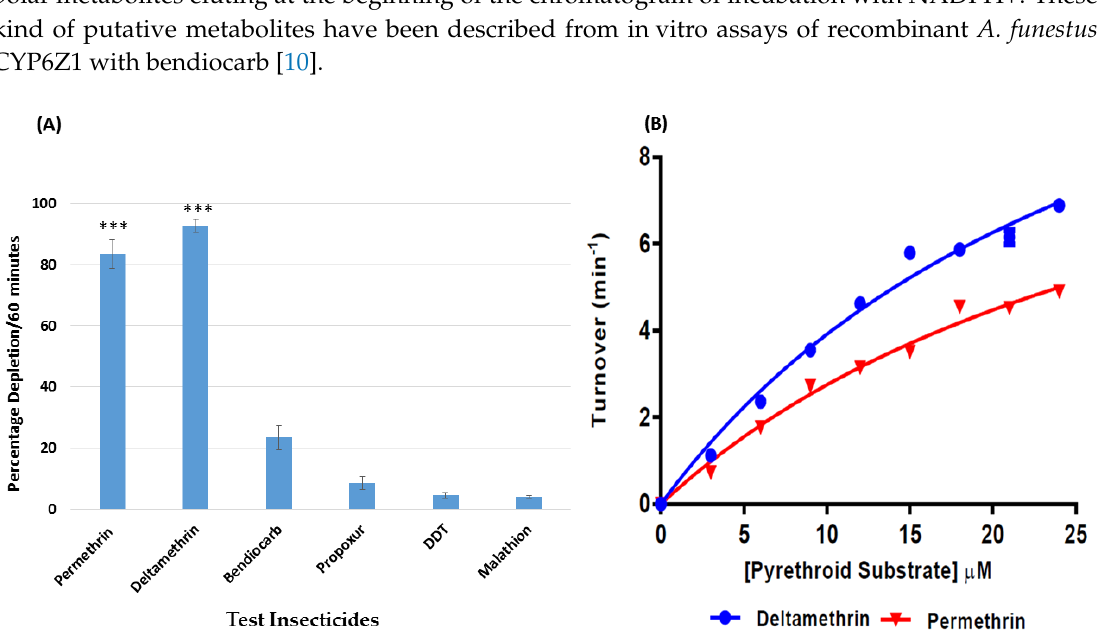
Figure 2. Metabolism of pyrethroids by recombinant A. funestus CYP6AA1. ( A ) Percentage depletion of various insecticides (20 µ M) with recombinant CYP6AA1; results are average of three replicates compared with negative control (-NADPH); *** Significantly different from -NADPH) at p < 0.005. ( B ) Michaelis-Menten plot of permethrin and deltamethrin metabolism by recombinant CYP6AA1 protein. Values are mean ± S.E.M. of three experimental replicates compared with negative control, without NADPH (-NADPH).